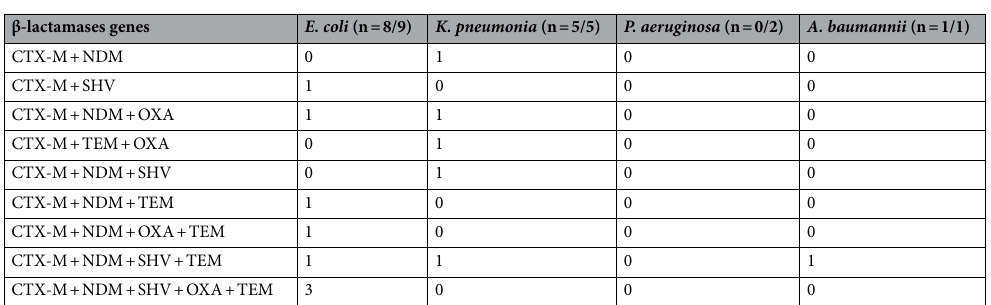
Table 4. Co-existence genes conferring resistance to β-lactams carbapenem drugs in Gram-negative